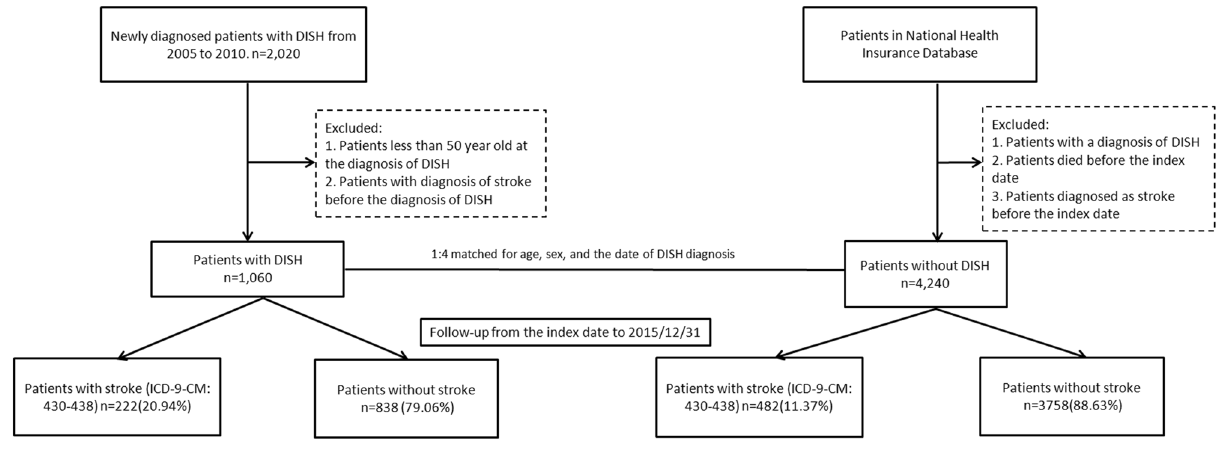
Figure 2. The flowchart of enrollment of study